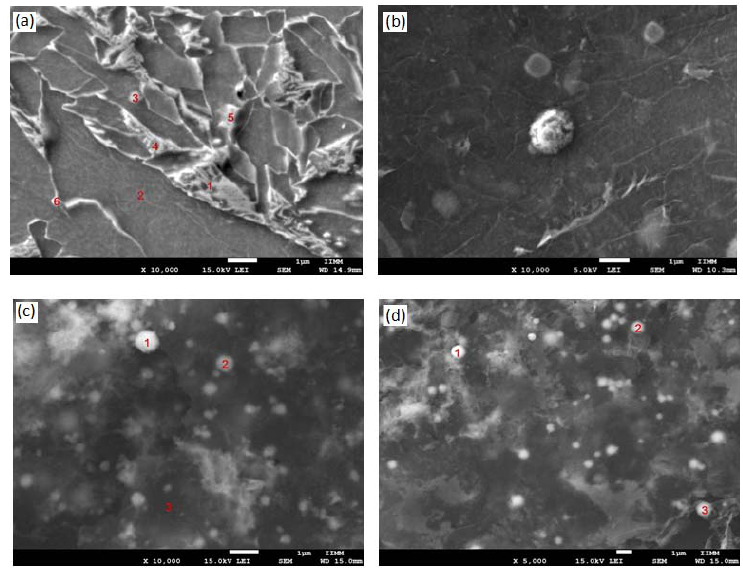
Figure 5. SEM micrographs of the ( a ) API ‐ X65 weldment that was over ‐ aged at 300 °C for three different aging times of ( b ) 6 h, ( c ) 15 h and ( d ) 45 h, respectively, showing fine Fe 3 C and Fe 2 C precipitates that were homogeneously distributed in ferritic grains.